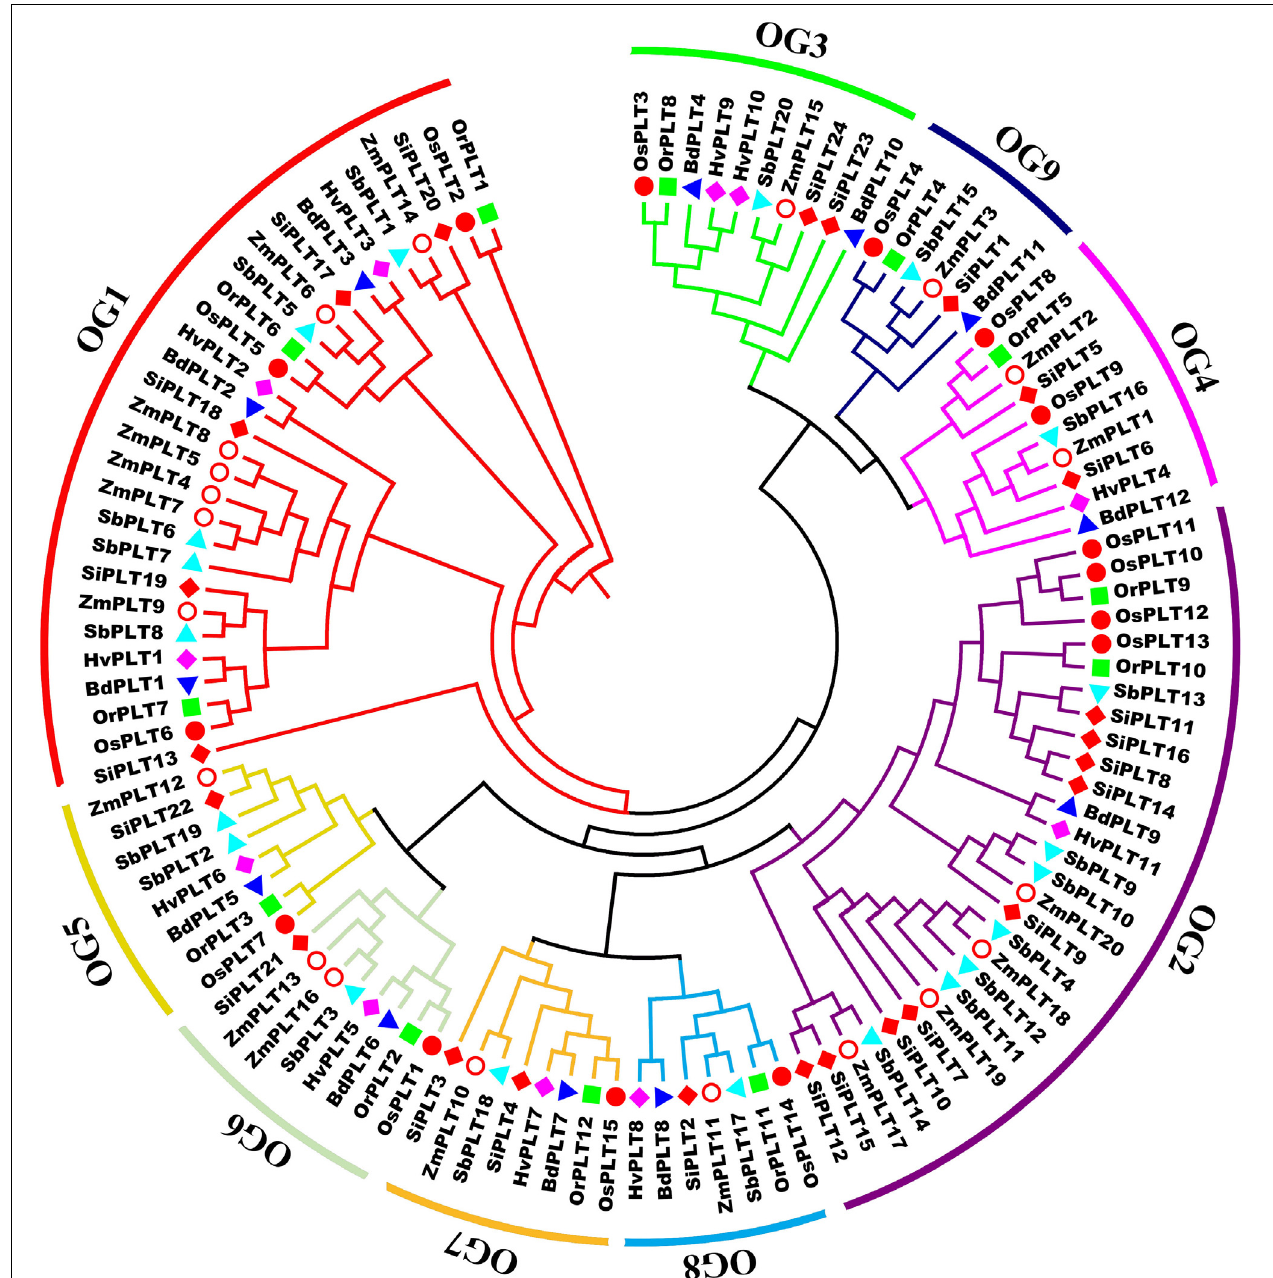
FIGURE 1 | A maximum likelihood phylogeny tree of the polyol transporter protein sequences from seven Gramineae crops, namely, Brachypodium distachyon (Bd), Hordeum vulgare (Hv), Setaria italica (Si), Sorghum bicolor (Sb), Zea mays (Zm), Oryza rufipogon (Or), and Oryza sativa ssp. japonica (Os). This tree was established by IQ-tree software with a 1,000-replicate bootstrap test and a 1,000-random-addition-replicate SH-aLRT test. The colors in the outside circles and the inside branches represent different orthogroups (OG), including OG1, OG2, OG3, OG4, OG5, OG6, OG7, OG8, and OG9. Markers of different shapes markers indicate the different species in the phylogeny tree. The orthogroup analysis was performed using OrthoFinder v2.0 software with default parameters.